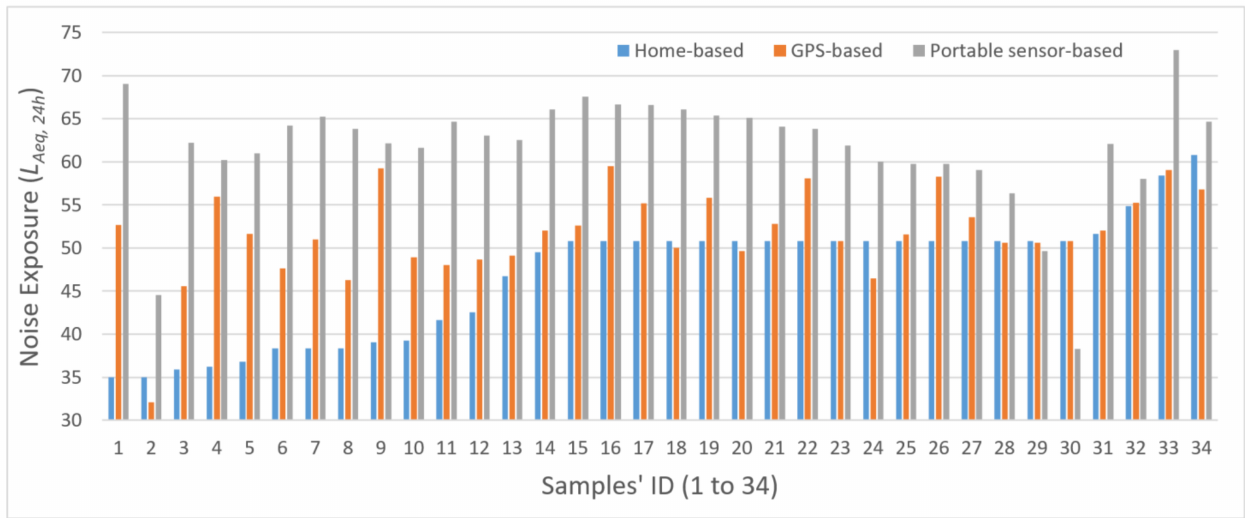
Figure 4. Comparison of individual noise exposure estimated by the three methods (home-based, GPS-based, and portable sensor-based) for each